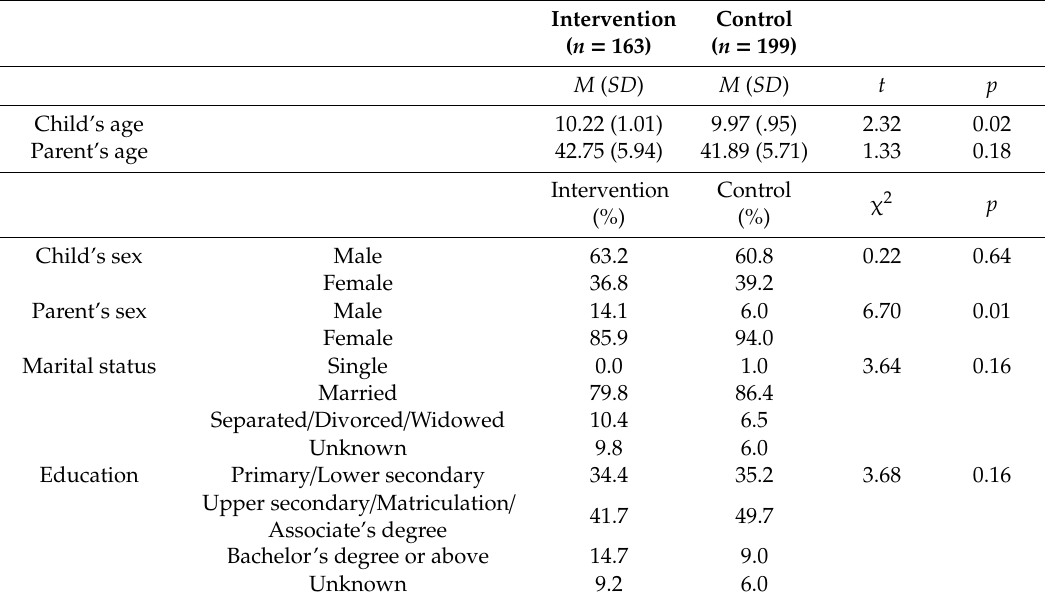
Table 1. Demographic characteristics of sample by